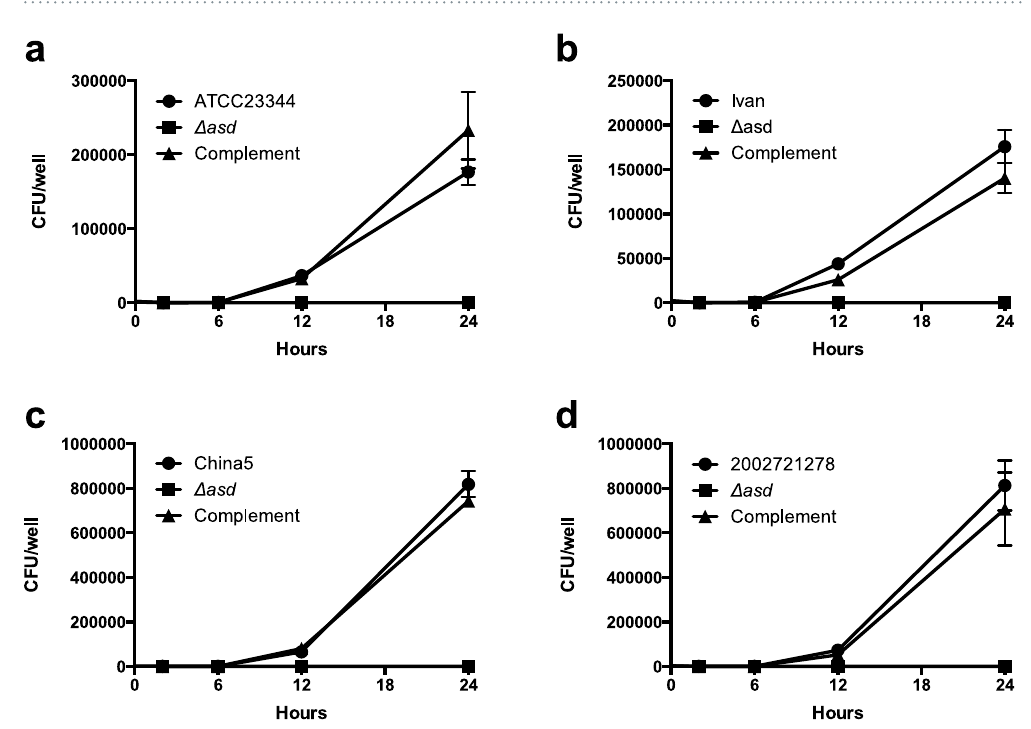
Figure 4. In vitro attenuation of Bm Δ asd strains in RAW264.7 murine macrophages. Bm strains ATCC23344 (a) , Ivan (b) , China 5 (c) , 2002721278 (d) were able to replicate well within the intracellular environment (circles) while the Δ asd counterparts showed complete abolishment of the ability to replicate intracellularly (squares). Complementation of the Δ asd gene in each Bm strain rescued the intracellular replication defect